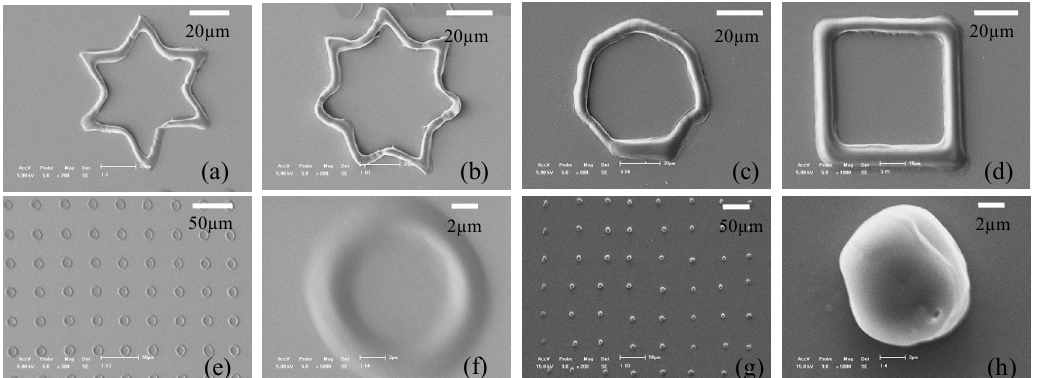
Figure 5. (a-d) show SEM images of hydrogel structures with different geometries. (a-b) are the geometric structures using deposition time of 2 minutes; (c-d) are the geometric structures of hydrogels using deposition time of 3 minutes. An AFM (atomic force microscope) was used to measure the height of these structures, and the results show structures in (a) and (b) are about 1.25 μm high, while structures in ( c) and (d) are about 2.45 μm, indicating that image projection time of an image on the ODEP chip will affect polymer structure thickness. (e-h) show SEM images of different arrays of structures. (e) shows the partial of 16 × 16 “ring” array with the scale bar of 50 µm and depositing time of 10 s, (f) shows the close-up of one “ring” in (e) with a height of ~180 nm. (g) shows a “point” array using deposition time of 3 min, and (h) shows the close-up of one point in (g) with a height of 4.40 µm.